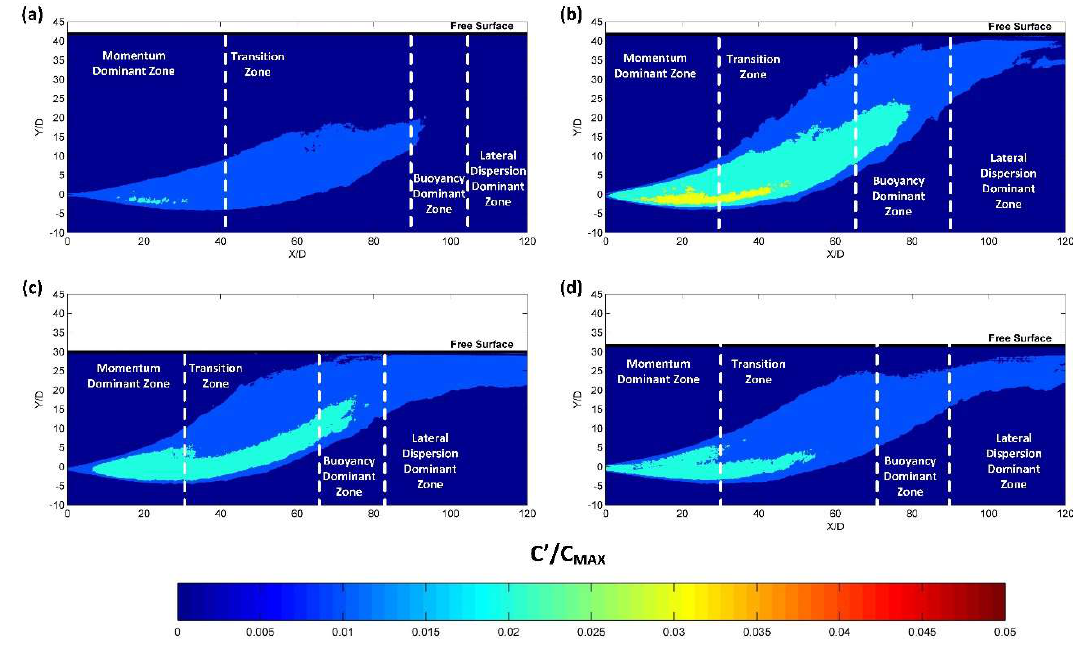
Figure 6. Dimensionless time-averaged fluctuations of the concentration (C’ / C MAX ) in a longitudinal view of the positively buoyant jet advance at the nozzle XY plane for the physical tests V1 ( a ), V2 ( b ), V3 ( c ), and V4 ( d ).